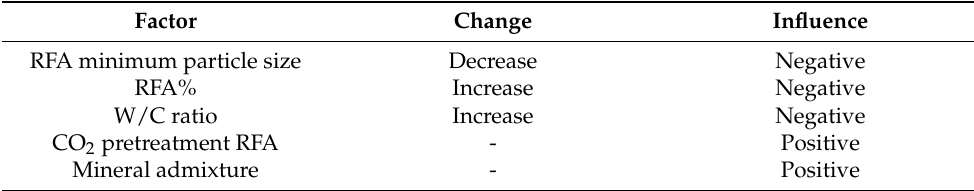
Table 2. The influence of different factors on the anti-carbonation performance of RFAc. Factor